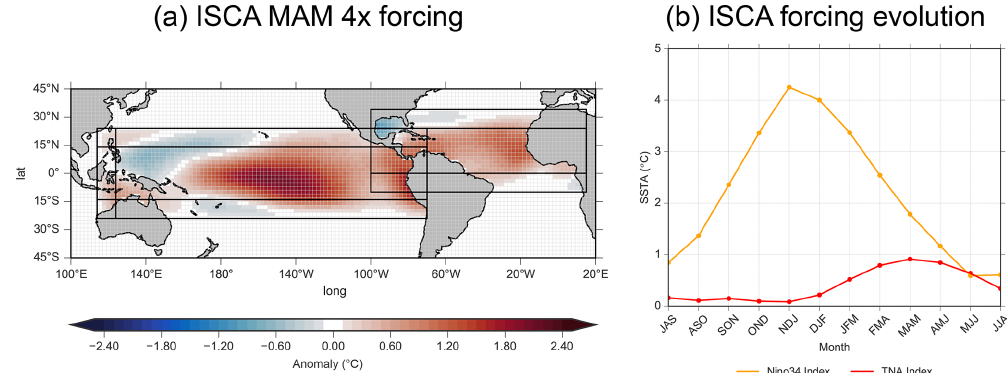
Figure 1. Forcing areas and seasonal evolution used to force Isca. Panel (a) depicts March–May (MAM) SST forcing for the AP runs (combined Pacific and Atlantic forcing). Black outlines indicate areas where regression was used, with outside rectangles indicating transition areas of linear decrease (see Fig. S1 in the Supplement for percentages). Panel (b) shows the seasonal evolution of Niño3.4 (orange) and TNA (red) indices using a 3-month running